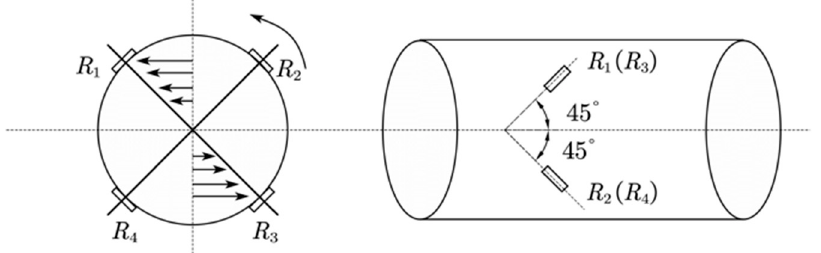
Figure 2. Schematic diagram of the torque sensor detection principle. R 1–4 represent torque strain gauges.